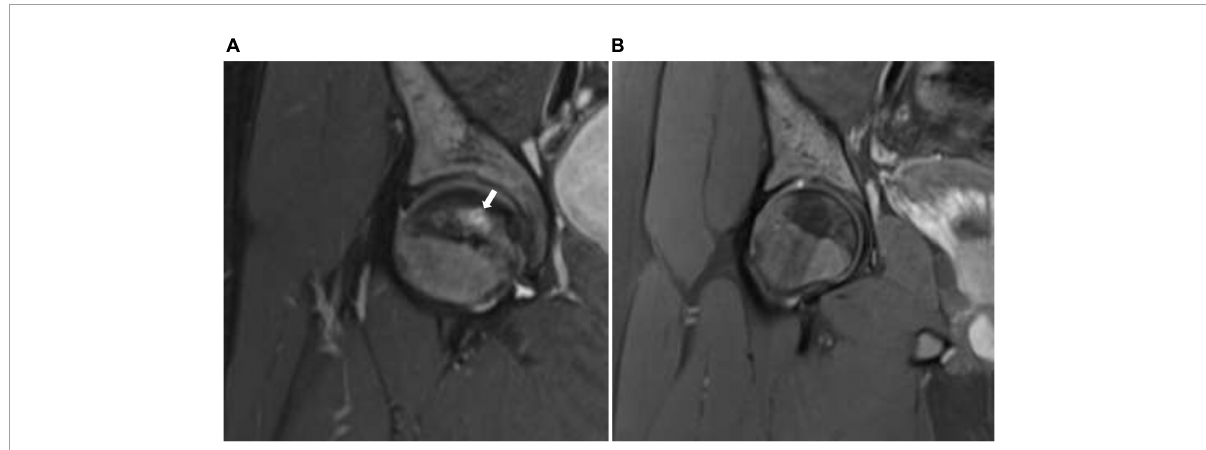
FIGURE1 (A) Coronal STIR (short T1 inversion recovery) of the right hip before treatment with HBO showing geographic subarticular area of high-signal intensity (arrow) with no collapse of the head of the femur (stage II). (B) Coronal STIR (short T1 inversion recovery) of the right hip after treatment showing complete resolution of the previously seen subarticular high-signal intensity suggests complete radiological resolution of avascular